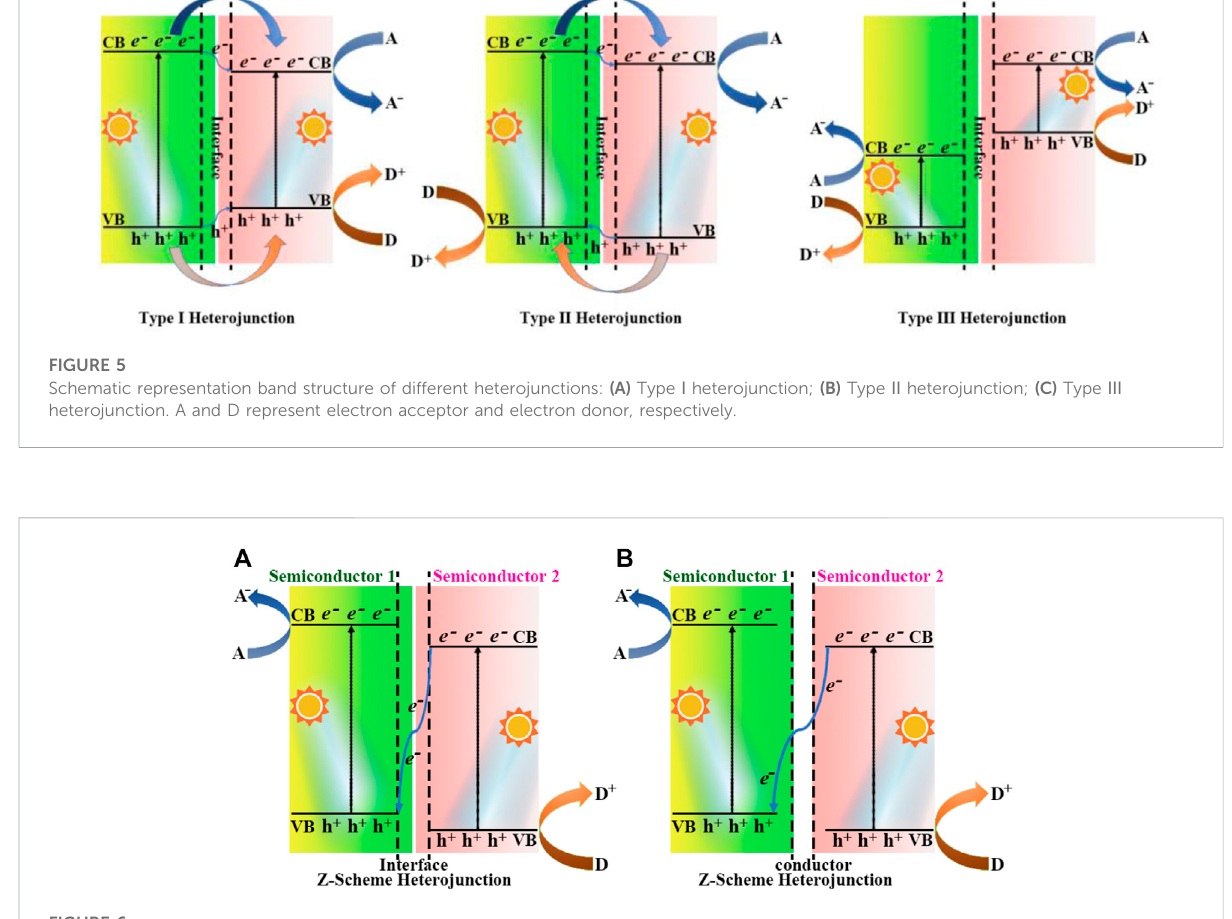
FIGURE 6 SchematicenergybanddiagramoftwodifferenttypesofZ-schemeheterojunction: (A) binaryZ-schemeheterojunction, (B) ternaryZ-scheme heterojunction. A and D denote electron acceptor and electron donor,